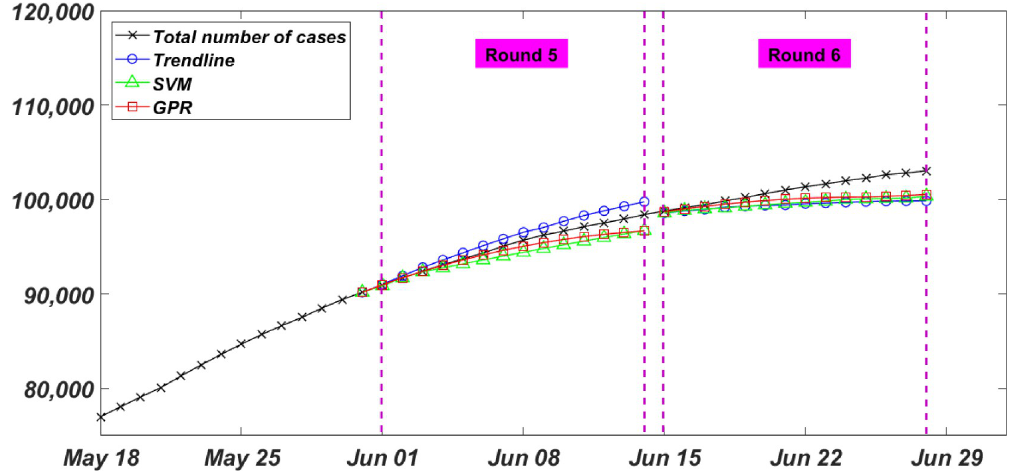
Fig 6. Rounds 5 and 6 of the bi-weekly total number of infected COVID-19 cases in Canada.